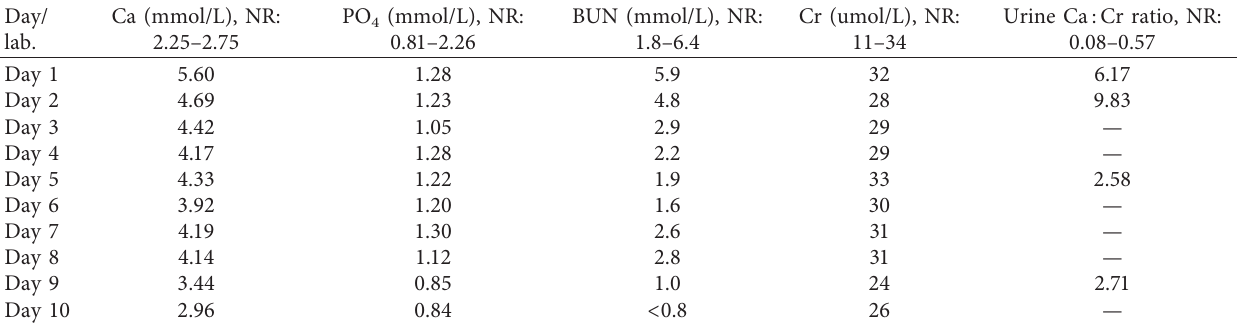
Table 1: Summary of daily laboratory results during patient’s hospital